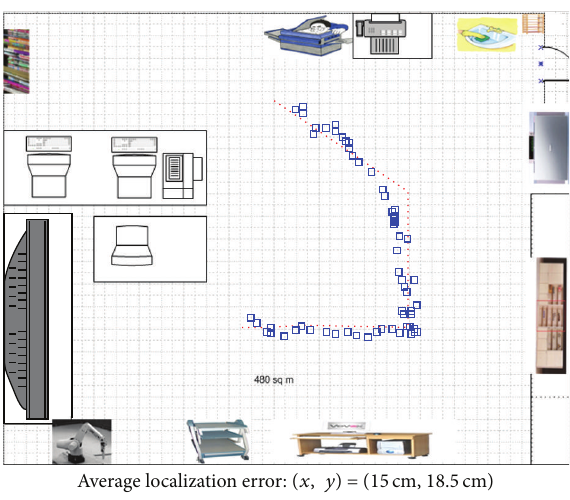
Figure 15: Overall localization performance of the test sequence using the proposed method.